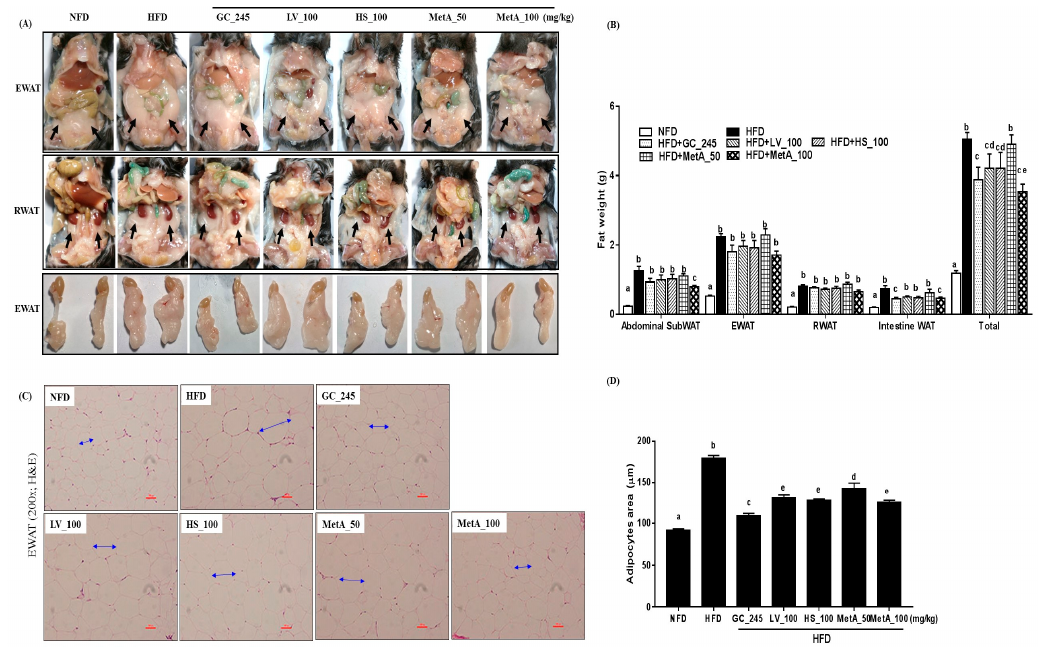
Figure 3. Effect of LV, HS, and MetA on WAT weight and morphology in HFD-induced obese mice. Representative images ( A ), final WAT weight ( B ), hematoxylin and eosin (H and E) staining of WAT ( C ), and adipocytes area ( D ) in NFD and DIO mice after 9 weeks of 60% HFD feeding. Images were captured under a light microscope at × 100 magnification. Abdominal subWAT, abdominal subcutaneous fat; EWAT, epididymal white adipose tissue; RWAT, retroperitoneal white adipose tissue; Total, abdominal subWAT + EWAT + RWAT + intestine adipose tissue. HFD, 60% high-fat-diet control group; HFD + GC_245, HFD contains Garcinia cambogia extract (245 mg/kg)-fed group; HFD + LV_100, HFD contains lemon verbena extract (100 mg/kg)-fed group; HFD + HS_100, HFD contains Hibiscus flower extract (100 mg/kg)-fed group; HFD + MetA_50, HFD contains the MetA-mixed extract of lemon verbena plus Hibiscus flower (50 mg/kg)-fed group; HFD + MetA_100, HFD contains the MetA-mixed extract of lemon verbena plus Hibiscus flower (100 mg/kg)-fed group. Values are expressed as means ± SEM ( n = 10). a–e Values within arrow with different letters are significantly different from each other at p < 0.05 as determined using Turkey’s multiple-range test.